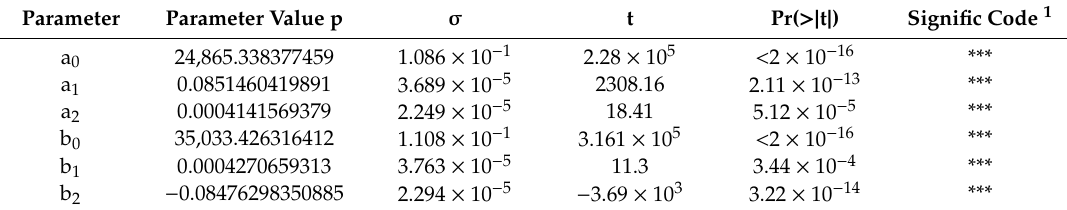
Table A1. A ffi ne transformation parameter value p, standard error σ , t value (t = P significance codes.